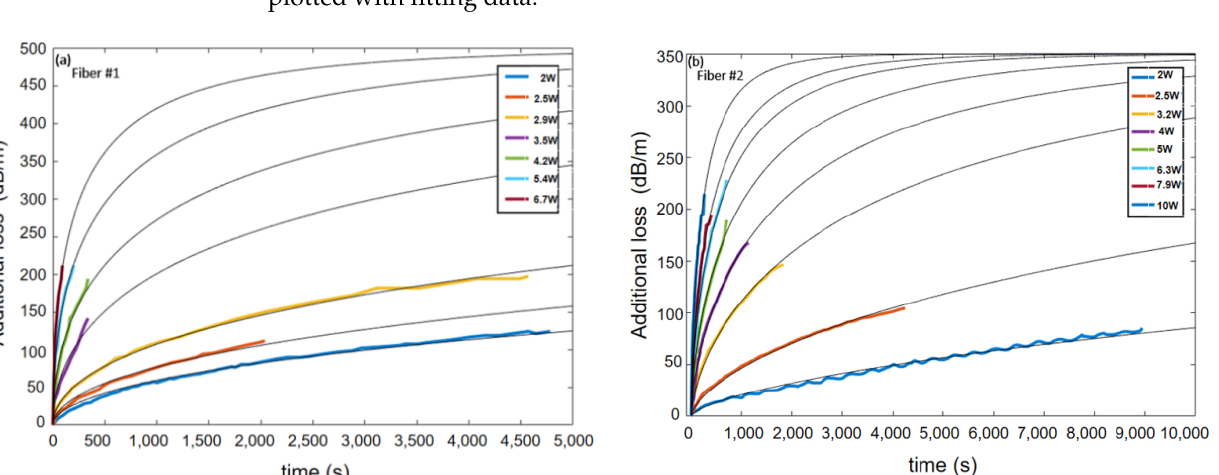
Table 1. Calculated PD rates under different pump powers of Fiber